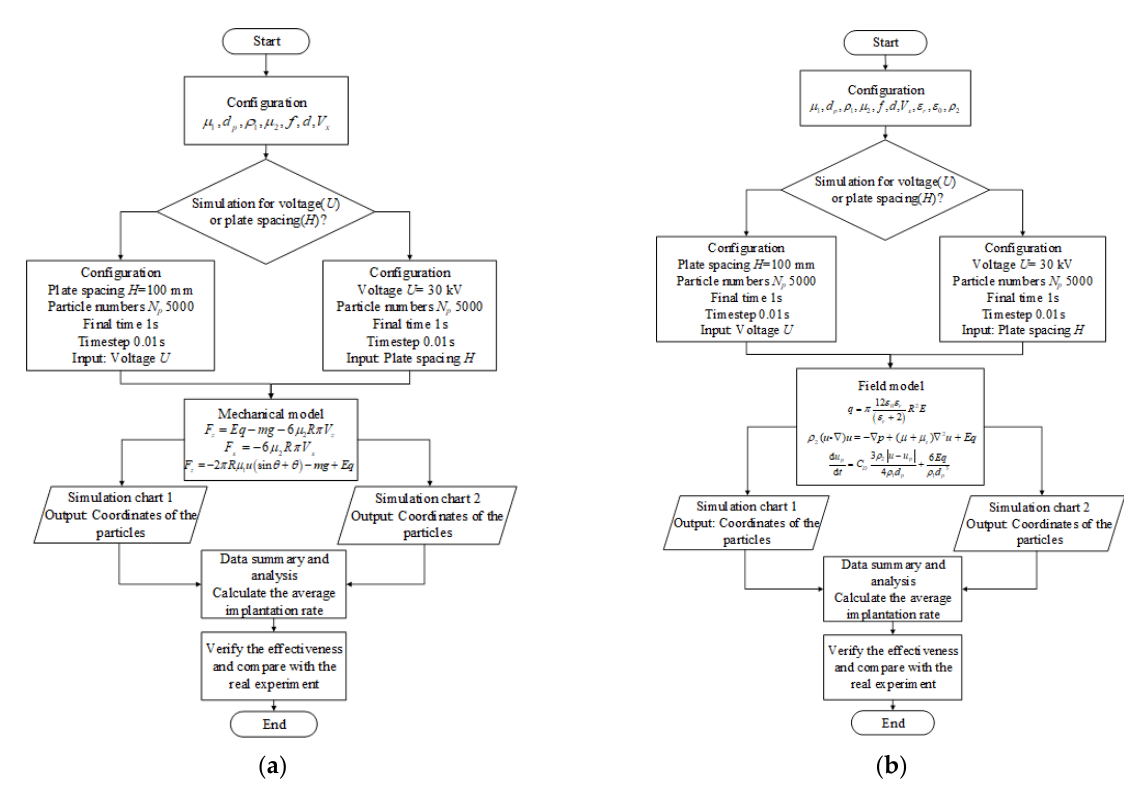
Figure 12. F lowchart of the numerical procedure: ( a ) mechanical model; ( b ) field model. Figure 12. Flowchart of the numerical procedure: ( a ) mechanical model; ( b ) field